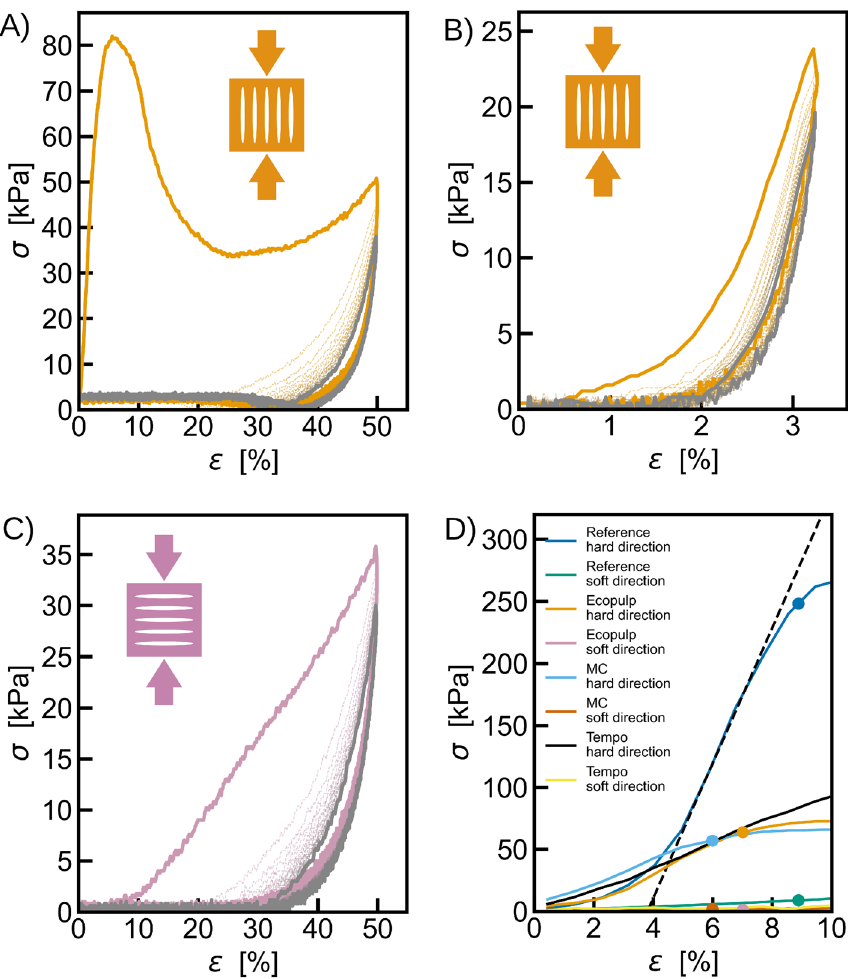
Figure 7. Determining the strength of material. ( A )–( C ) The elastic response of the material was tested on cyclic compression experiments with 20 cycles. The coloured solid lines represent the first cycle and the gray solid lines the 20th cycle. The samples were produced from Ecopulp and they were tested on the hard direction with ( A ) 50% compression and ( B ) 3.5% compression. ( C ) Similar test was conducted for soft direction with 50% strain. ( D ) The beginning part of the average stress-strain curves showing the determination of the yield stress (dots) using the linear fit to the maximum slope of the elastic part (black dashed line as an example). In the soft direction the yield stress is determined as the stress value corresponding to the strain which equals the yield strain of the compression in the hard